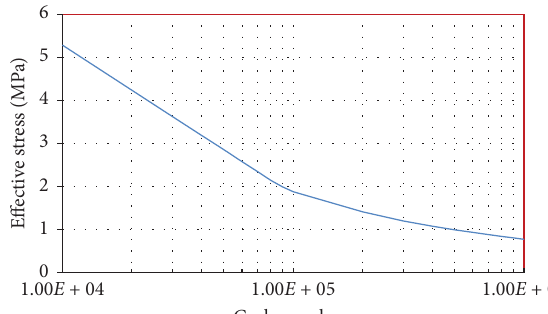
Figure 6: The S-N curve.